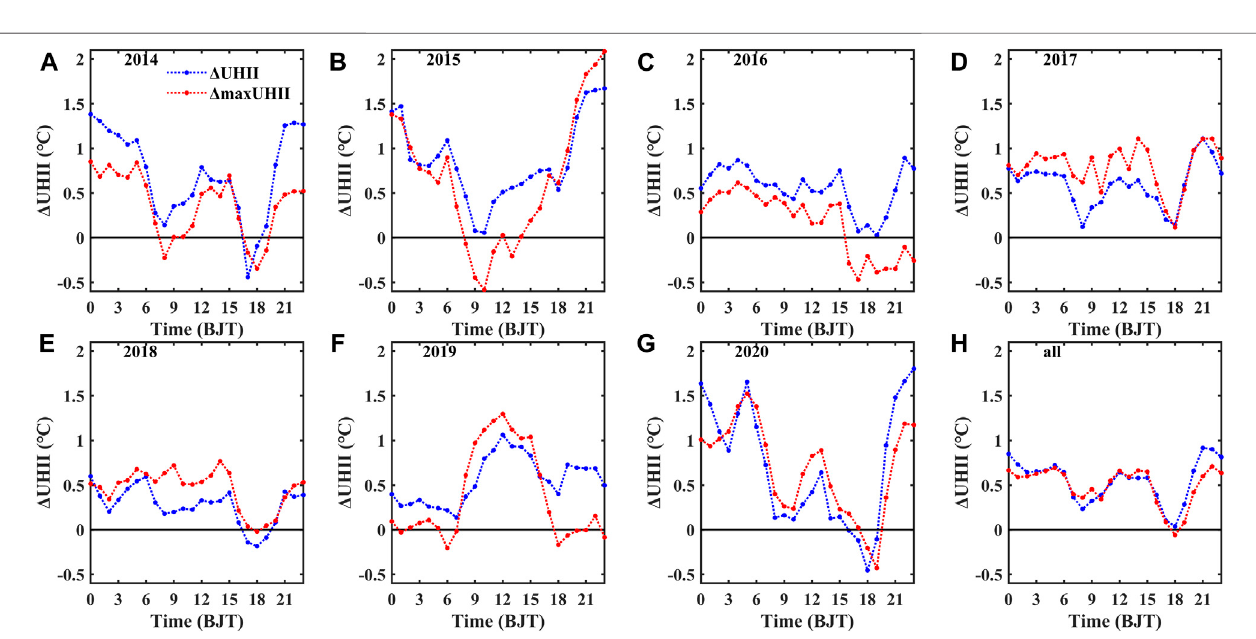
FIGURE 3 | Diurnal differences in UHII between HW and NHW periods during summertime (June – August) 2014 – 2020. Red lines present average maximum UHII values, and blue lines present average UHII values according to all urban reference stations.